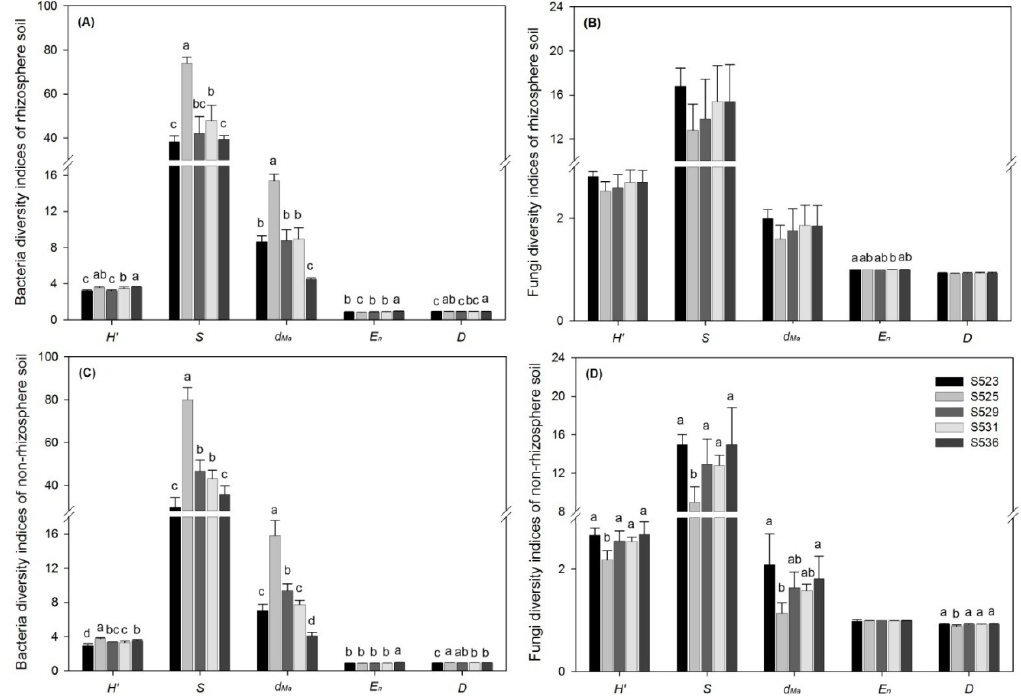
Figure 4. Shannon-Wiener index ( H’ ), Species richness ( S ), Margalef ( d Ma ), Evenness ( E n ), and Simpson index ( D ) of rhizosphere ( A , B ) and non-rhizosphere ( C , D ) soil bacteria ( A , C ) and fungi ( B , D ) community in different sub-dams. Different letters (a, b and c) indicate significant differences, according to Duncan’s test ( p < 0.05).